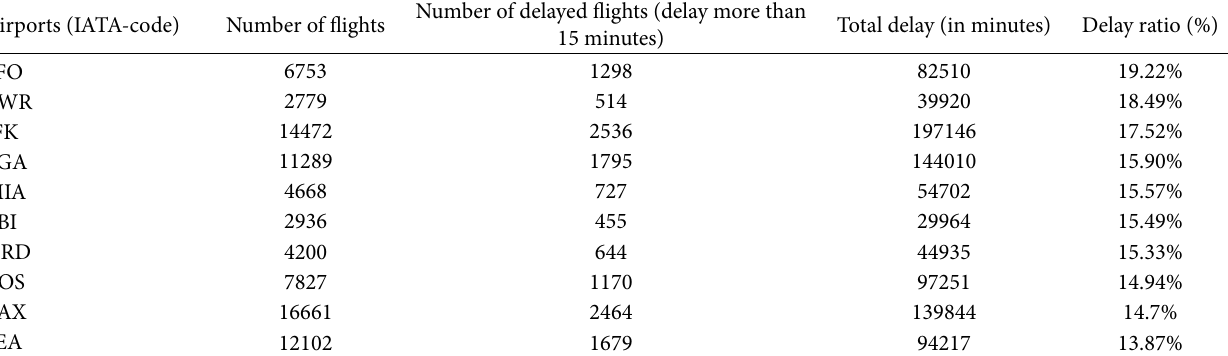
Table 2: Statistical results of 10 airports with the highest delay ratio.